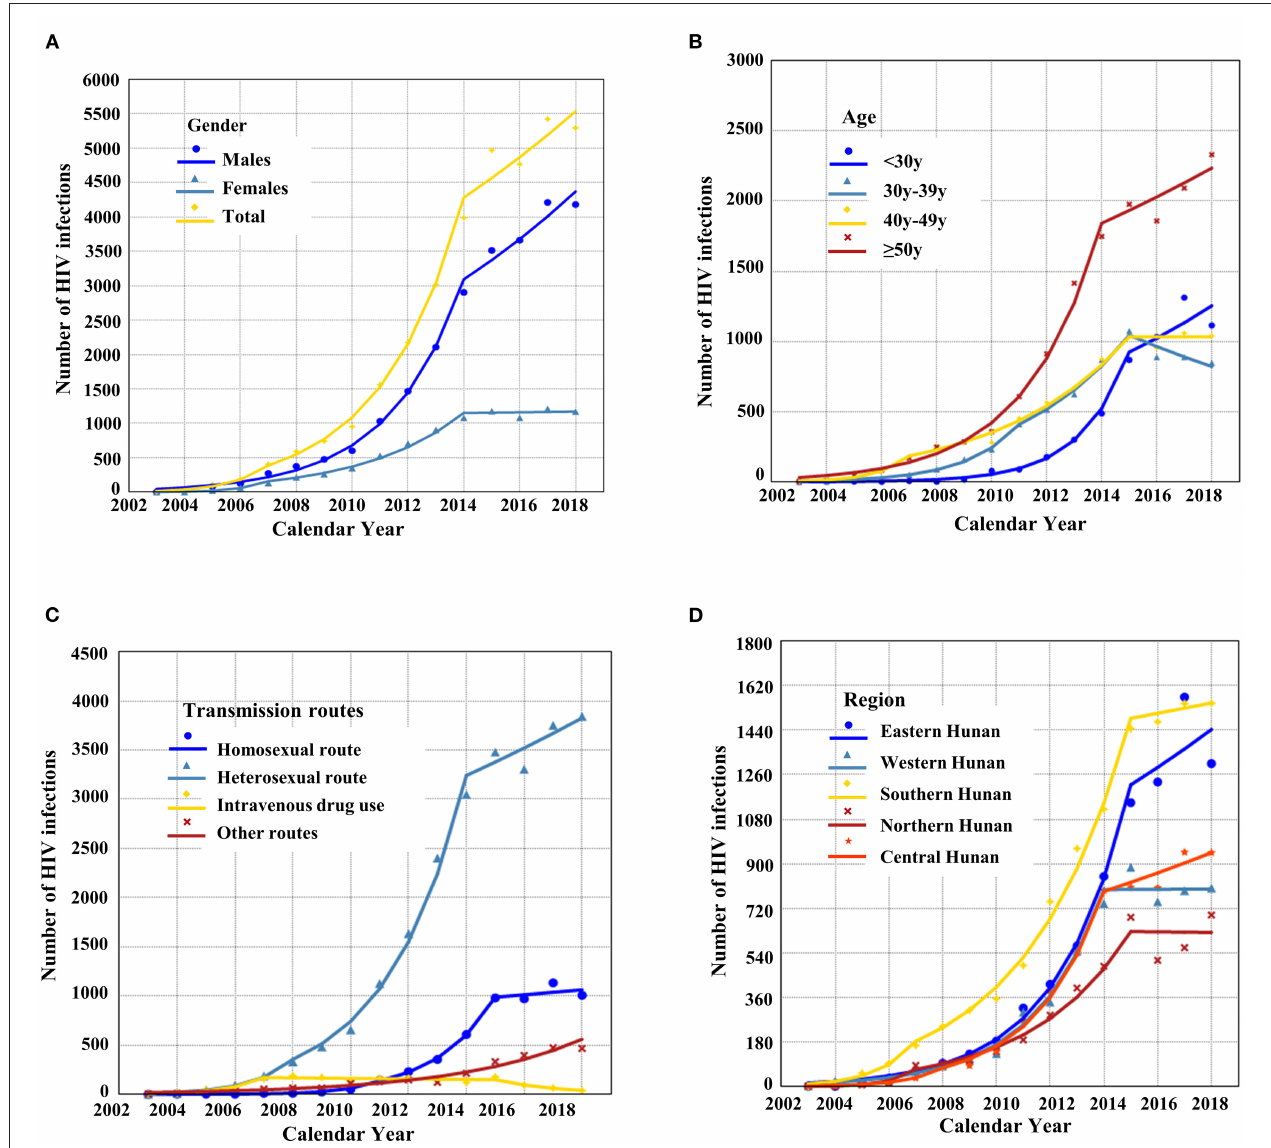
FIGURE 2 | The temporal trend of the total number of HIV-1 infections (A) and HIV infections is stratified by gender (A) , age (B) , transmission (C) , and region (D)